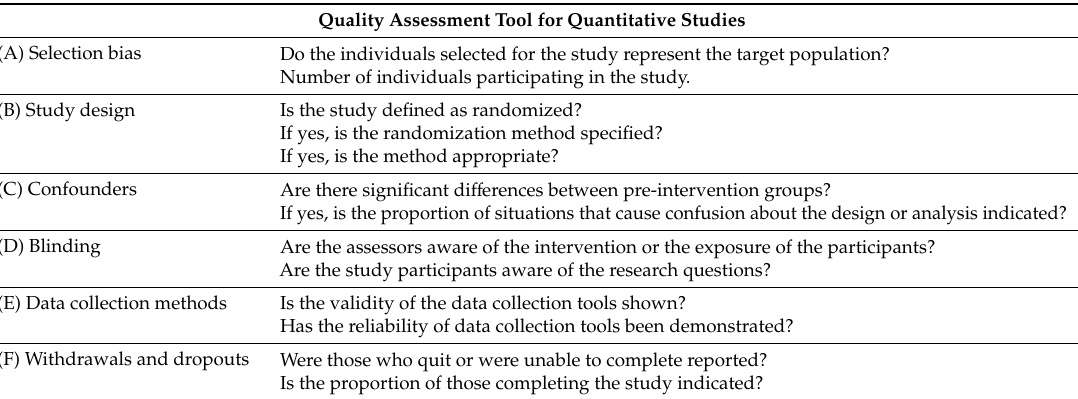
Table 1. Quality assessment for